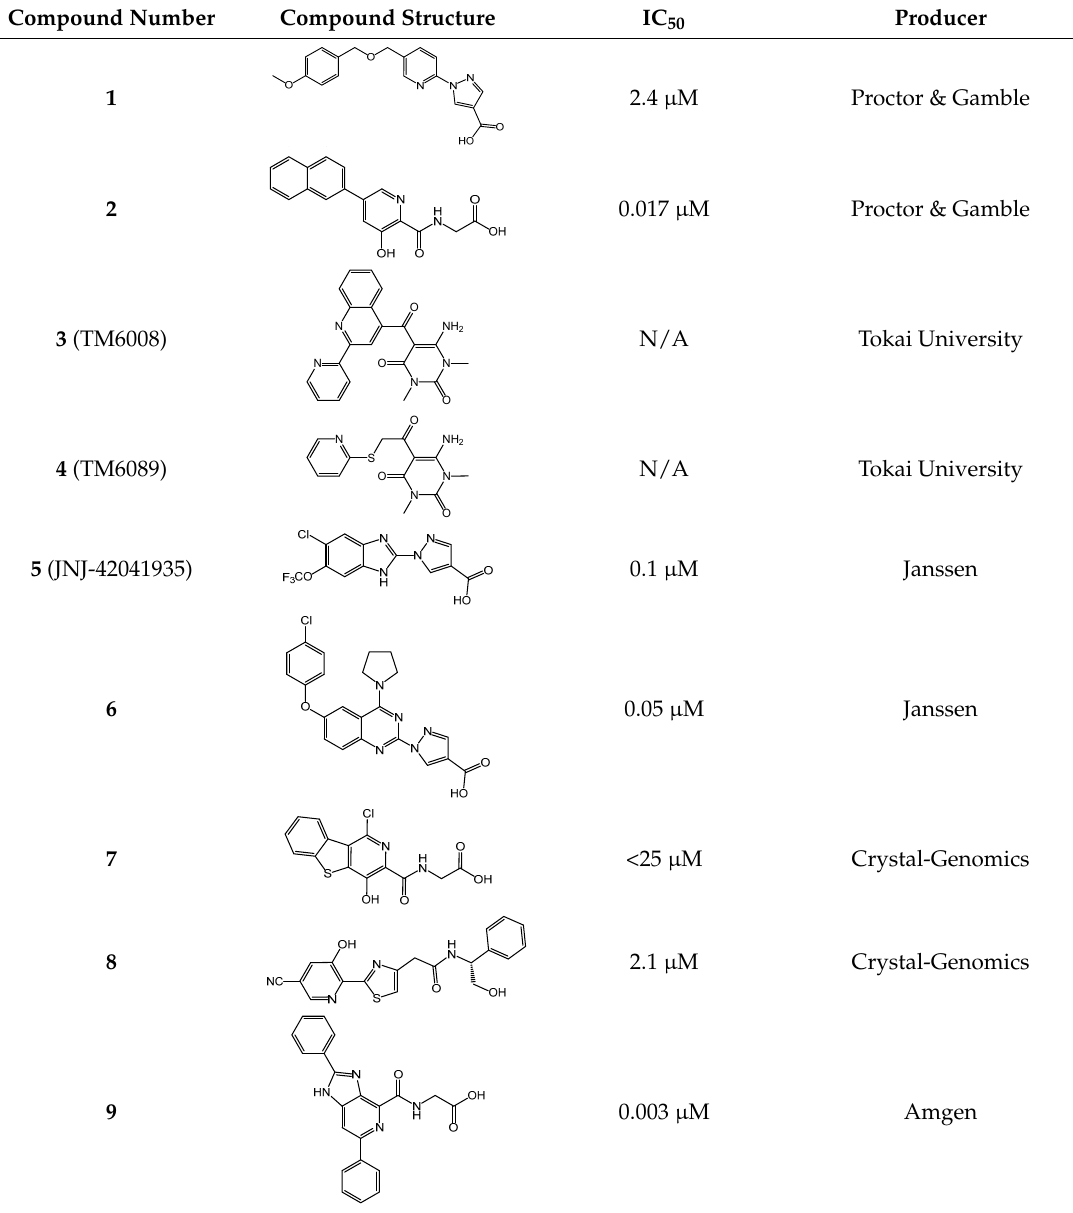
Table 2. PHD inhibitors developed by SBDD.